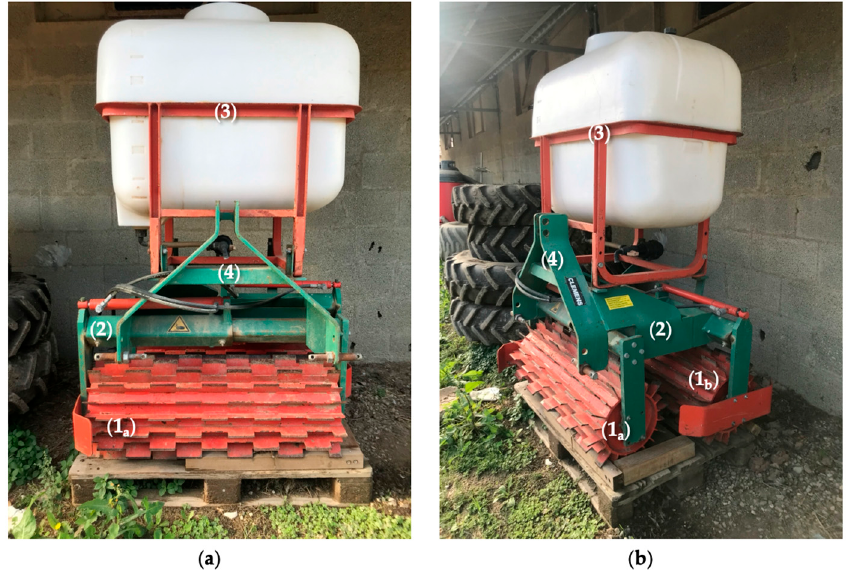
Figure 3. Front ( a ) and lateral ( b ) view of the commercial roller crimper Clemens Eco-Roll type: ( 1 a,b ) roller crimpers; ( 2 ) hexagon frame; ( 3 ) tank; ( 4 ) three-point